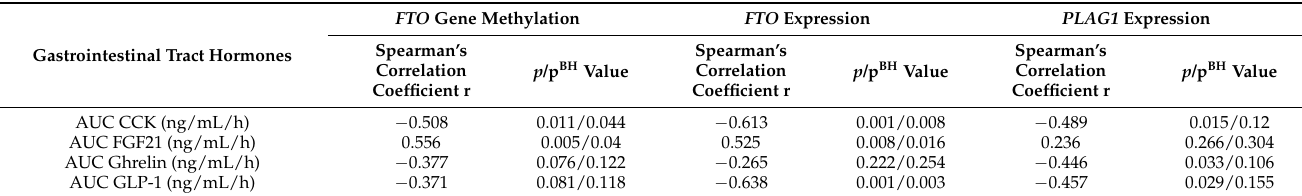
Table 5. Correlation results of the gastrointestinal tract hormones serum levels with the FTO gene methylation, expression and PLAG1 gene